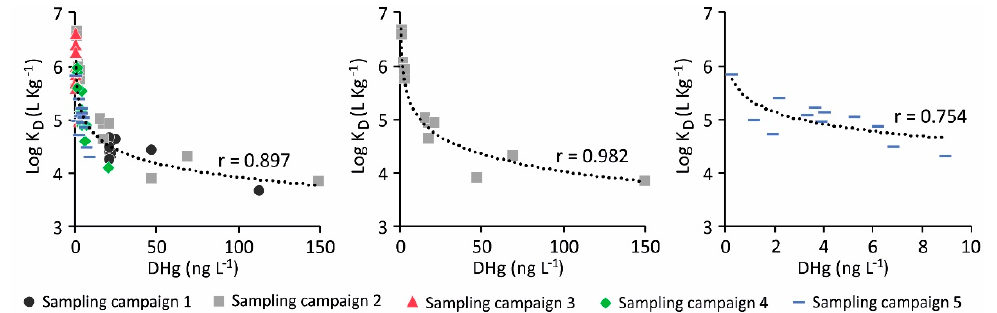
Figure 8. Relationship between logKD and dissolved DHg (ng L − 1 ) in surface and bottom water samples collected at the six investigated sites in the Bay of Panzano during sampling campaigns 1–5 performed under different environmental conditions. Best fit was obtained using a 2nd-order polynomial curve.